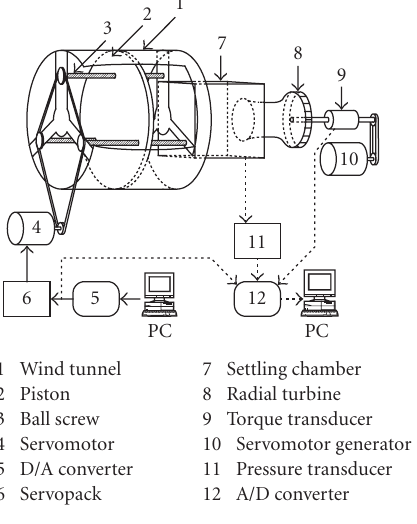
Figure 1: Test apparatus.